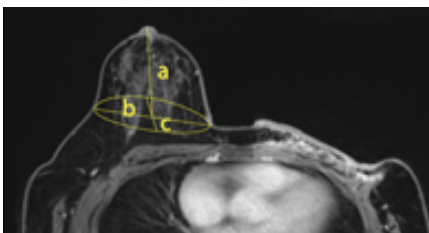
Figure 7. The MRI volume